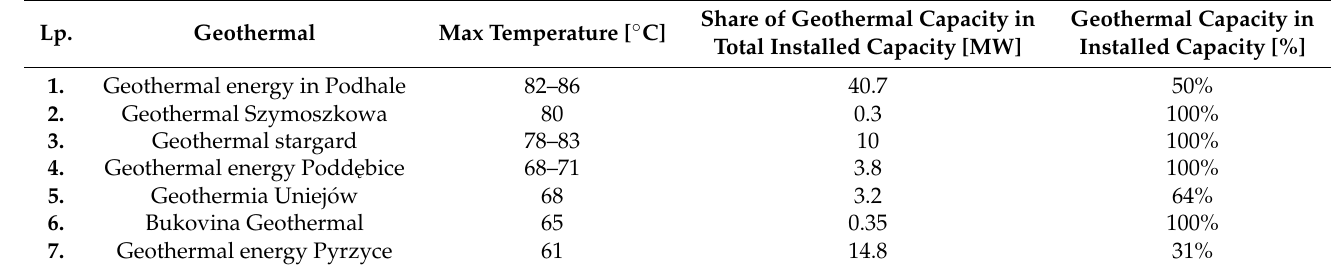
Table 1. Overview of selected deep geothermal installations in Poland